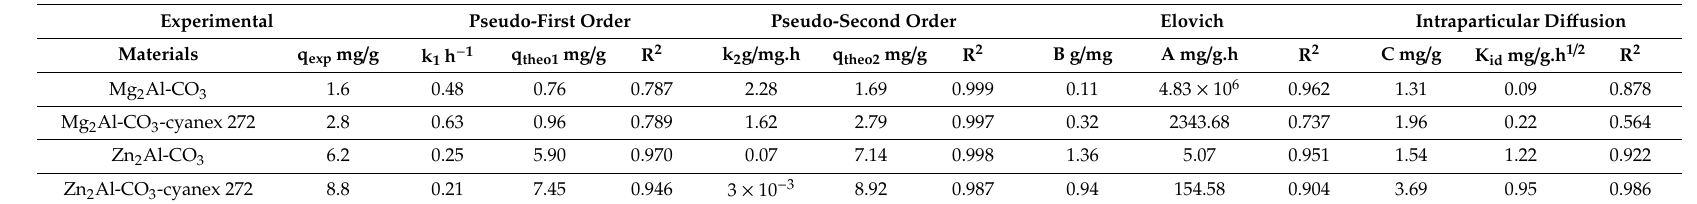
Table 2. Kinetic parameters for Zn(II) extraction by the di ff erent